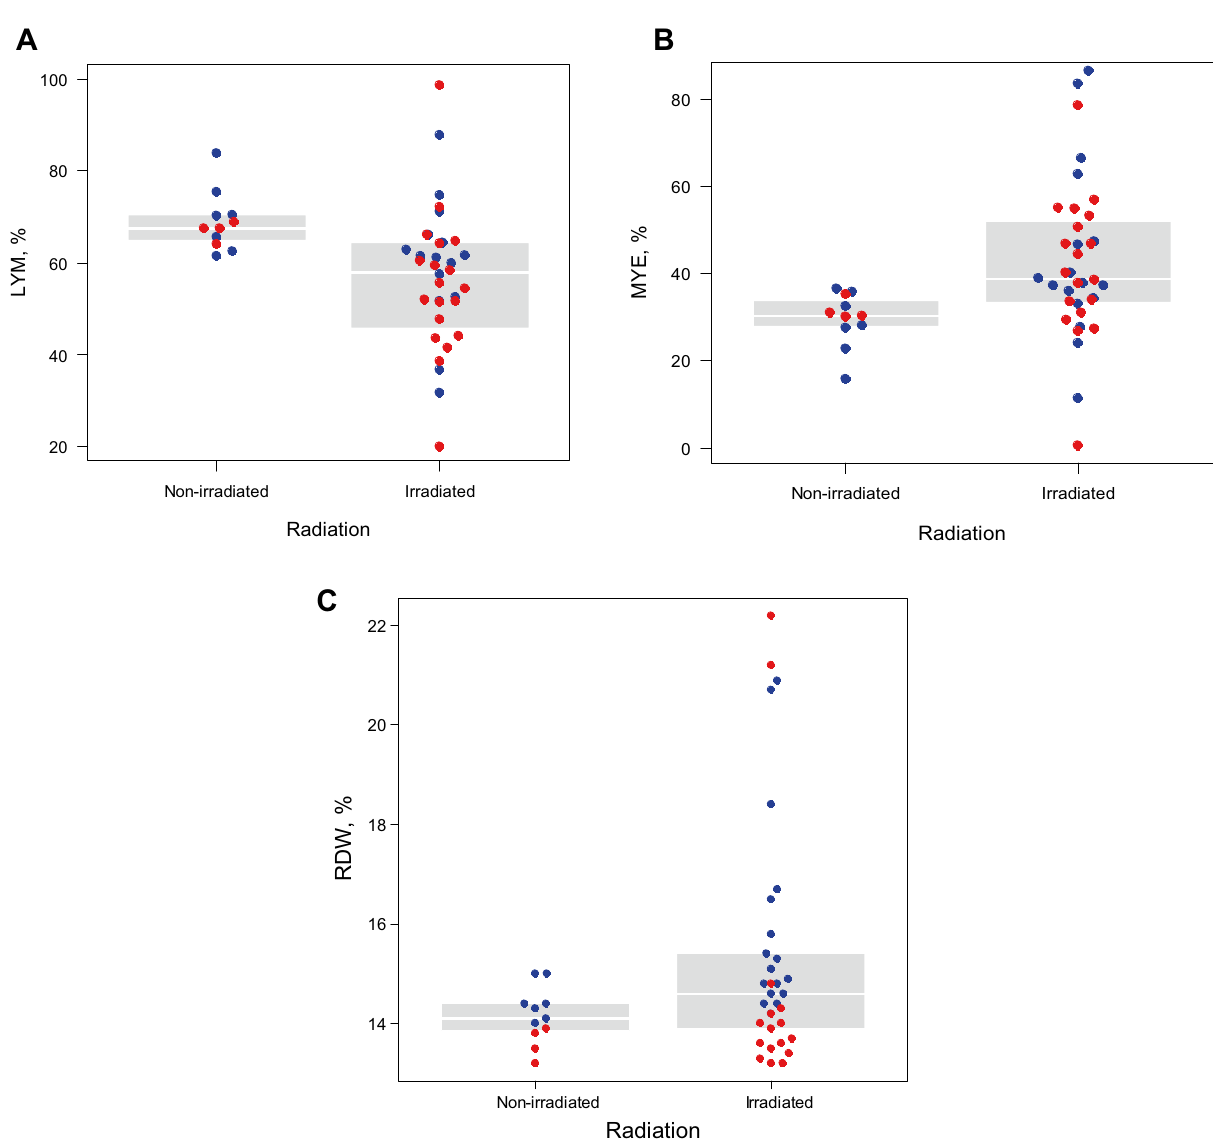
Figure 1. Blood cell profiles in mice 12–18 months post-irradiation. ( A ) Lymphocytes (LYM) were enumerated using flow cytometry as CD41 − and CD11b − cells in the peripheral blood leukocytes and compared between radiation-exposed (N = 36) and non-exposed (N = 11) mice. The LYM percentages were significantly different ( P < 0.01) based on linear-regression analysis after adjusting for age and sex. The blue and red dots represent male and female animals, respectively. Inter-quartile ranges are shown with gray-shaded areas. ( B ) Myeloid cell percentages (MYE, %) in the peripheral blood leukocytes were evaluated with CD41 − and CD11b + populations, including Ly6C-low granulocytes and Ly6C-high monocytes. The same statistical analysis indicated a significant difference between radiation-exposed (N = 36) and non-exposed (N = 11) mice ( P < 0.01). ( C ) RDW values of peripheral blood erythrocytes were measured using a hematological autoanalyzer in mice after irradiation. Three data were missing for irradiated mice because of sampling errors. The RDW values significantly differed between radiation-exposed (N = 33) and non-exposed (N = 11) mice ( P < 0.01). RDW, red blood cell distribution